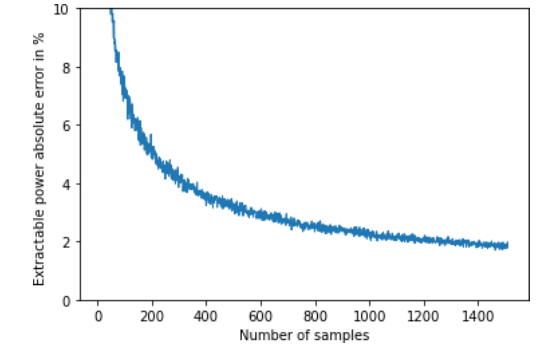
Figure 2. Accuracy of the method of the moment for estimating extractable wind power as a function of the number of samples.